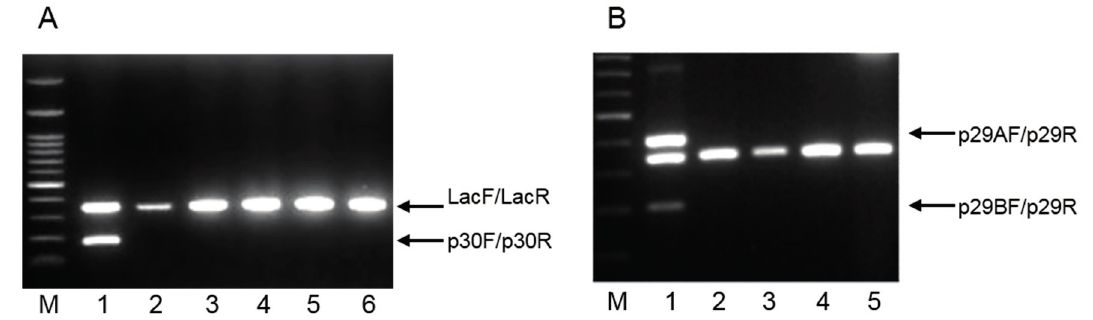
Figure 3. Agarose gel electrophoresis of PCR products from multiplex PCR assay.